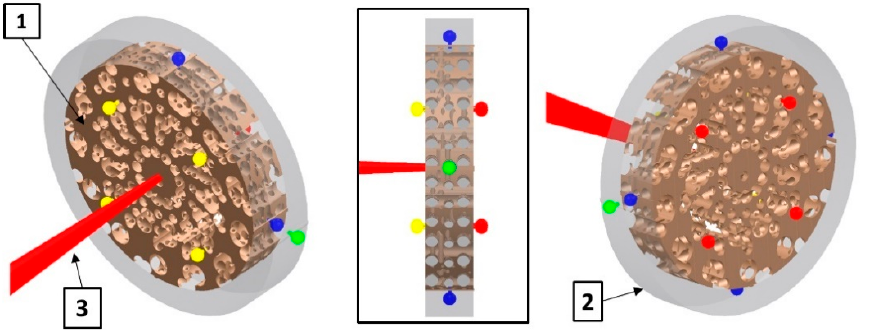
Figure 3. Distribution of thermocouple probes in the porous absorber (1): front face (yellow), rear face (red), absorber edge (blue), and insulation interface (green) (2). The red line indicates the direction of pyrometer readings (3).